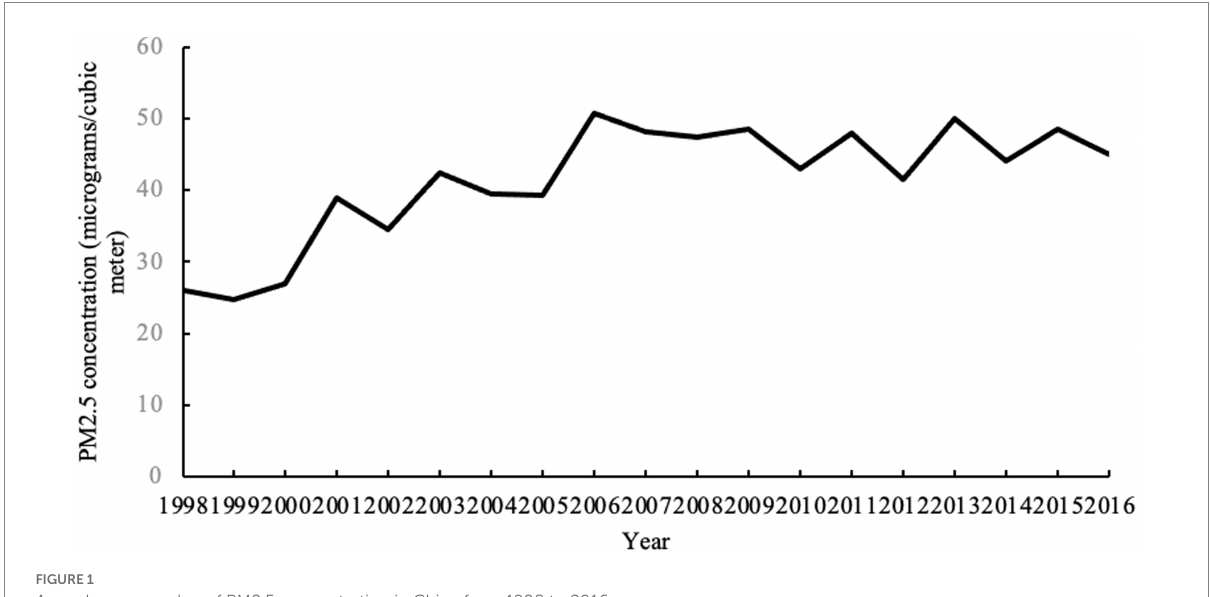
FIGURE 1 Annual average value of PM2.5 concentration in China from 1998 to